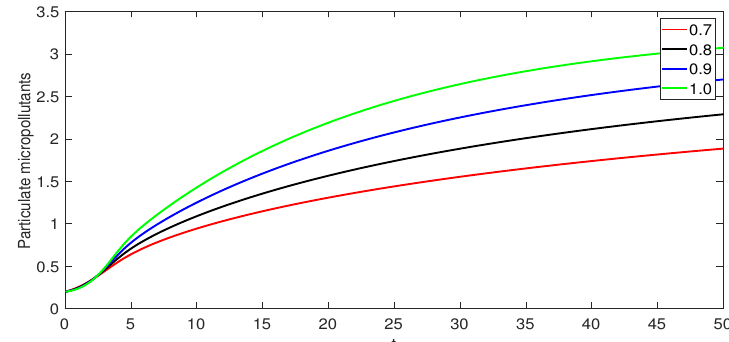
Figure 3. Graphical illustration of the model (8) for IBP and various values of δ .